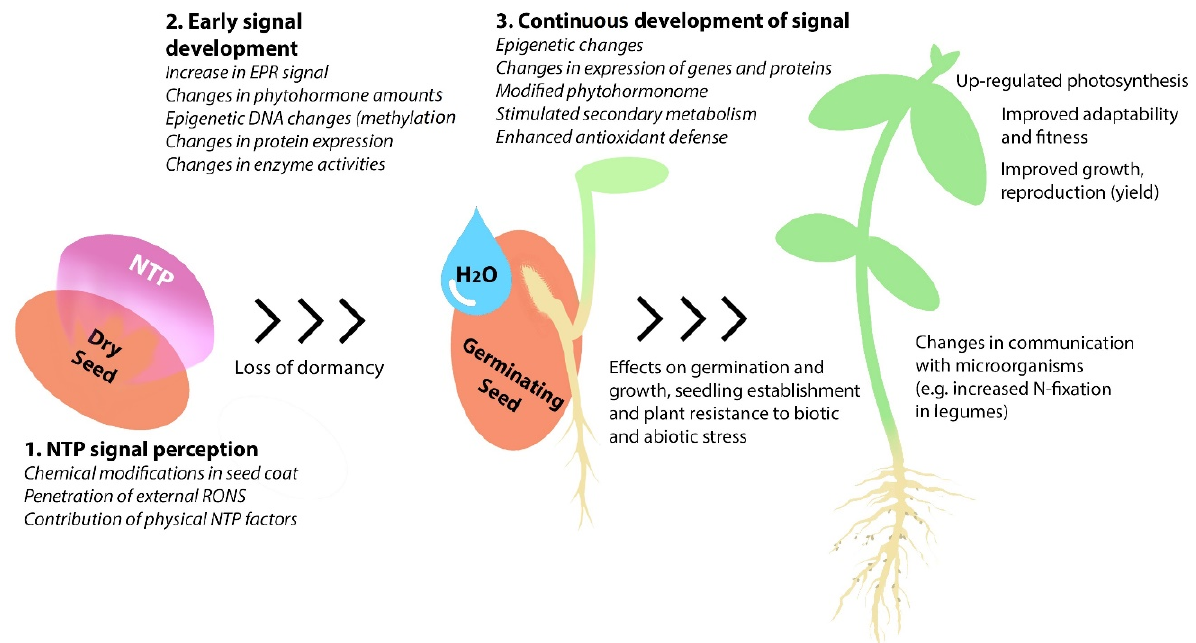
Figure 2. Schematic representation of three stages in the time course of the NTP-induced signal development in seeds and plants.